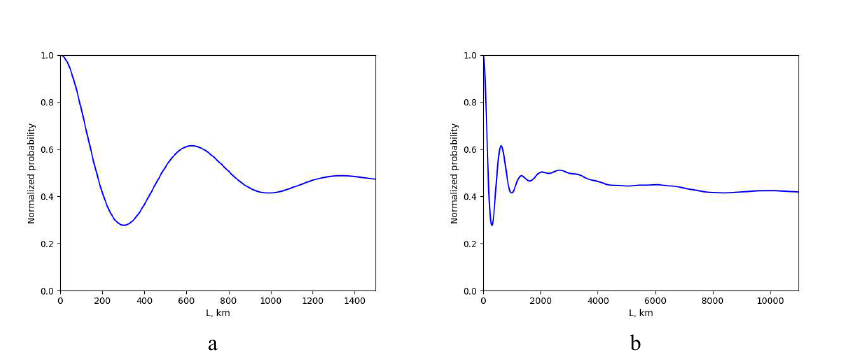
Figure 1. Normalized probability of the neutrino oscillation process with the detection by a nucleon and muon production on spatial scales a) 1500 km and b) 11000 km